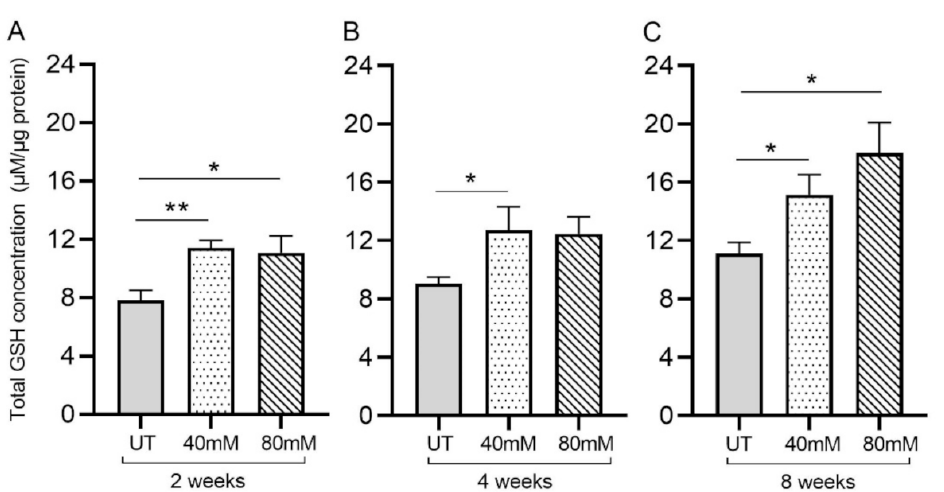
Figure 3. L-GSH supplementation significantly increased the total GSH levels in the M. tb -infected mice lungs. The total GSH levels in the lungs were measured spectrophotometrically. The lung lysates were collected from mice treated with 40 mM or 80 mM L-GSH or untreated mice at 2 weeks ( A ), 4 weeks ( B ), and 8 weeks ( C ) post-infection (p.i.). All of the values plotted for each group represent the mean values +/ − standard deviation. One-way ANOVA with Tukey’s multiple group post-correction was applied to determine the significance between groups, and a p -value of <0.05 (*) was considered significant. ** p < 0.01. Statistical analysis was performed using GraphPad Prism Software 8. The sample size is 6 mice (n = 6) per group, per time